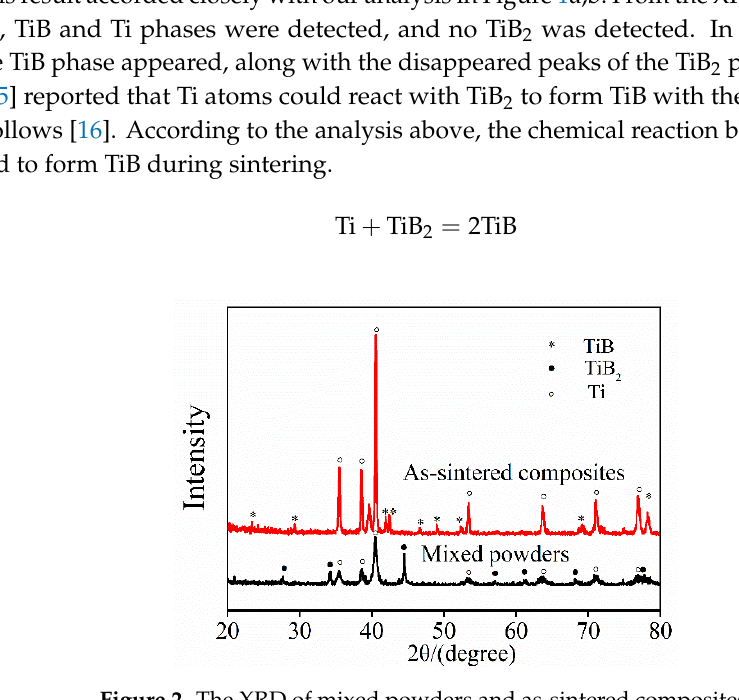
Figure 1. The process flowchart ( a ), SEM of spherical Ti-6Al-4V-powders ( b ), SEM of prismatic TiB 2 powders ( c ), SEM of mixed powders ( d ), SEM of as-sintered composites ( e ).